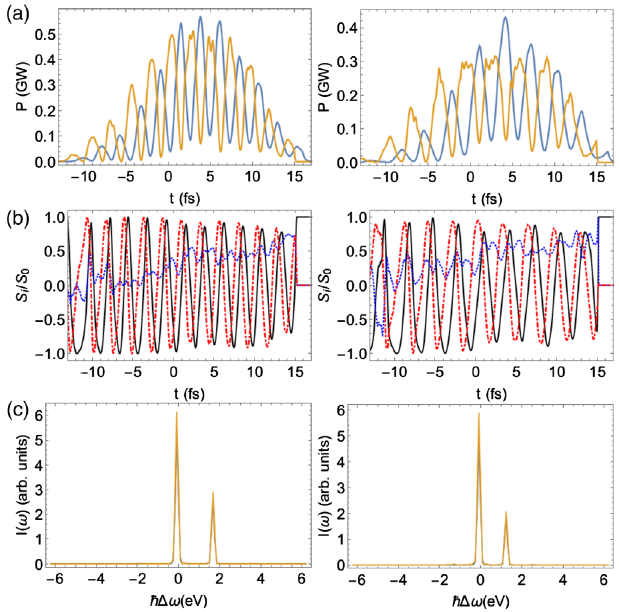
FIG. 5. Temporal modulation produced with two-color ESS. Left: 700 nm modulation Right: 1050 nm modulation. (a) Power in s -polarization (blue) and p -polarization (yellow). (b) Normal- ized Stokes parameters, S 1 =S 0 (black, line), S 2 =S 0 (blue, dotted), S =S 3 0 (red, dashed). (c) Spectral intensity in and p -polarization